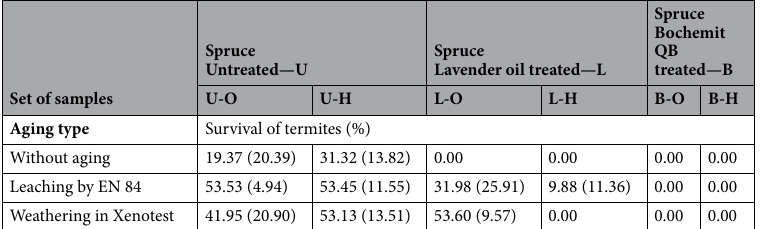
Table 2. Survival of termites after 6 weeks of termite attack by EN 118. Untreated original—(U-O); Untreated, but with the additional hydrophobic substance—(U-H); Treated with the lavender oil—(L-O); Treated with the lavender oil and then with the hydrophobic substance (L-H); Treated with the Bochemit QB—(B-O); Treated with the Bochemit QB and then with the hydrophobic substance—(B-H). Mean values are from 6 replicates; Numbers in parentheses are